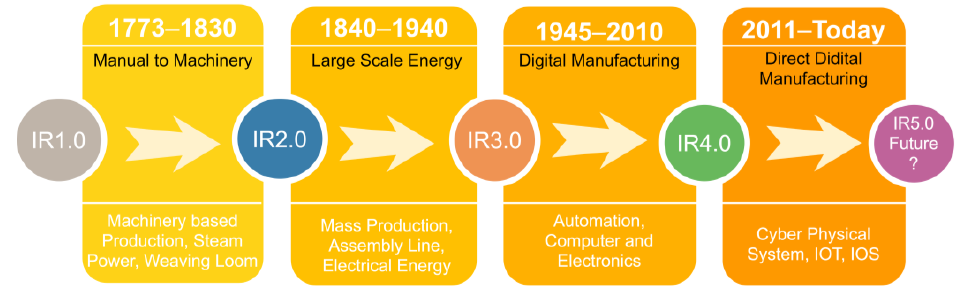
Figure 1. Chronological outline of industrial revolutions.